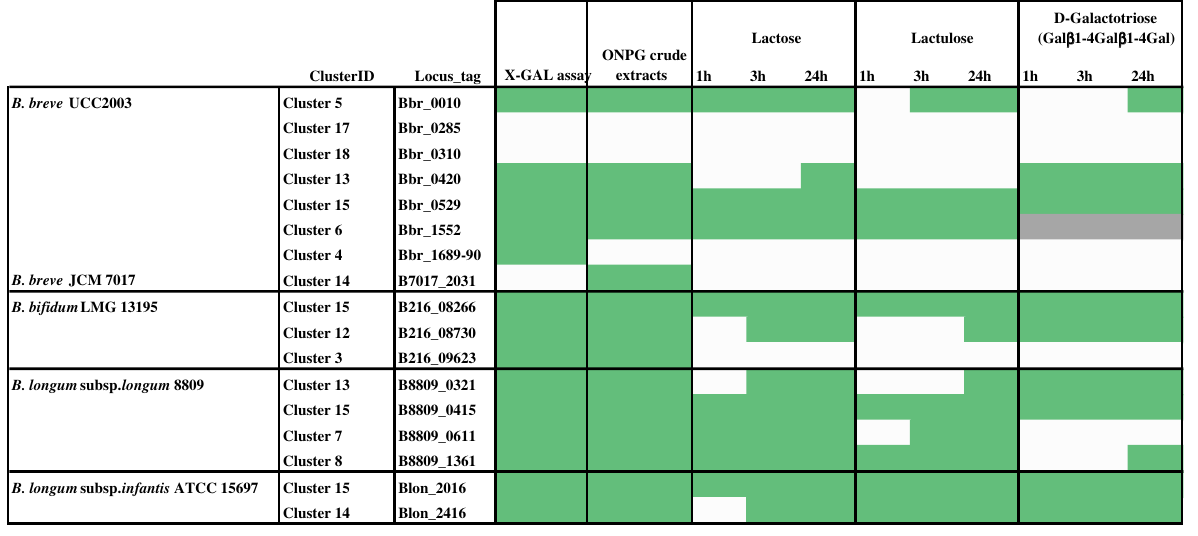
Key to colour coding: Substrate hydrolysis observed (green), no hydrolysis (white) and substrate not assayed (grey). Results of X-gal and ONPG assays are also reported for comparative